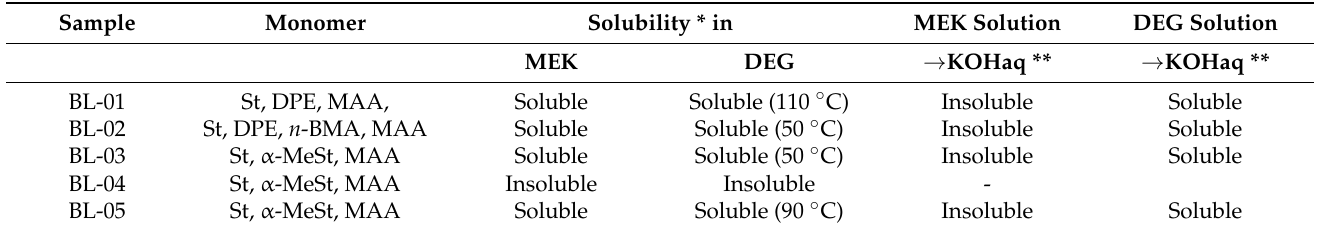
Table 4. Polymer solubility in the KOH solution from the solvent solution.